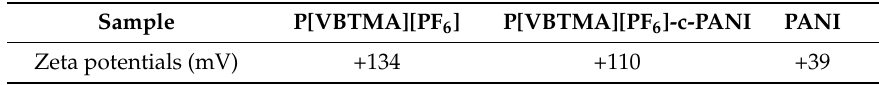
Table 1. Zeta potentials of P[VBTMA][PF 6 ], P[VBTMA][PF 6 ]-c-PANI, and PANI particles. Sample